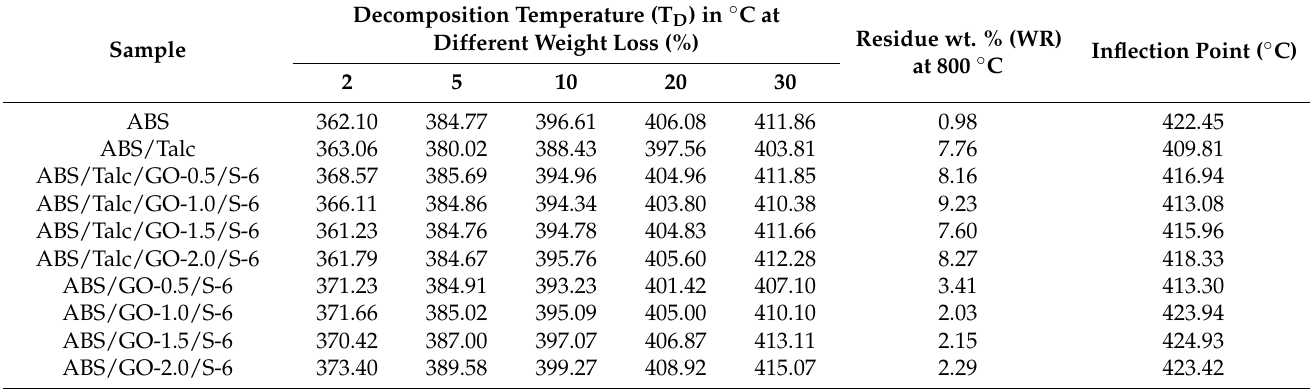
Table 5. Thermogravimetric analysis (TGA) data of ABS and ABS/talc composites with different loading amounts of GO.